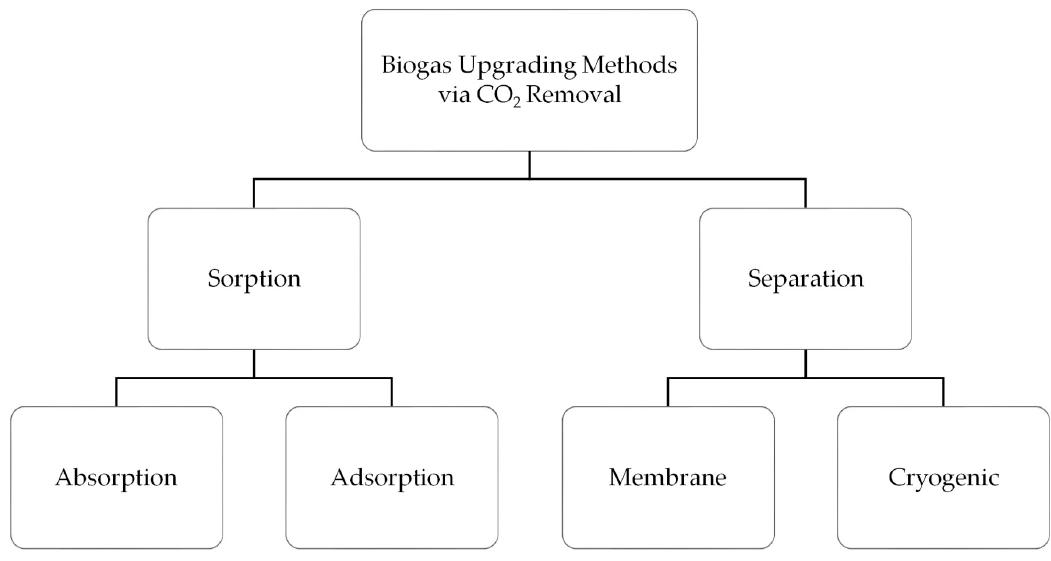
Figure 1. Technologies for biogas upgrading via CO 2 removal route.